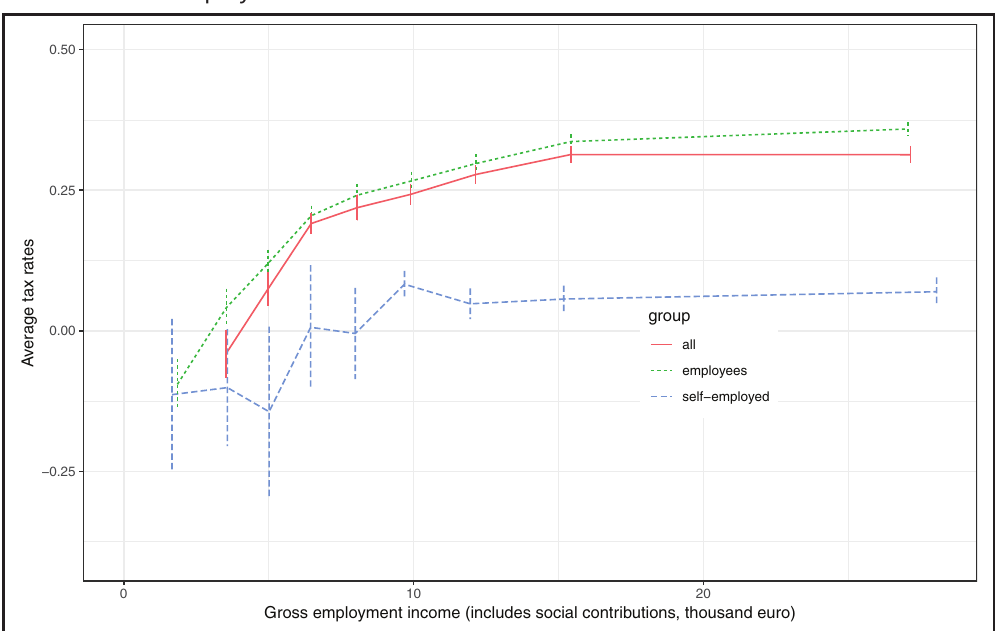
Net taxes are higher and more progressive for employees than for the